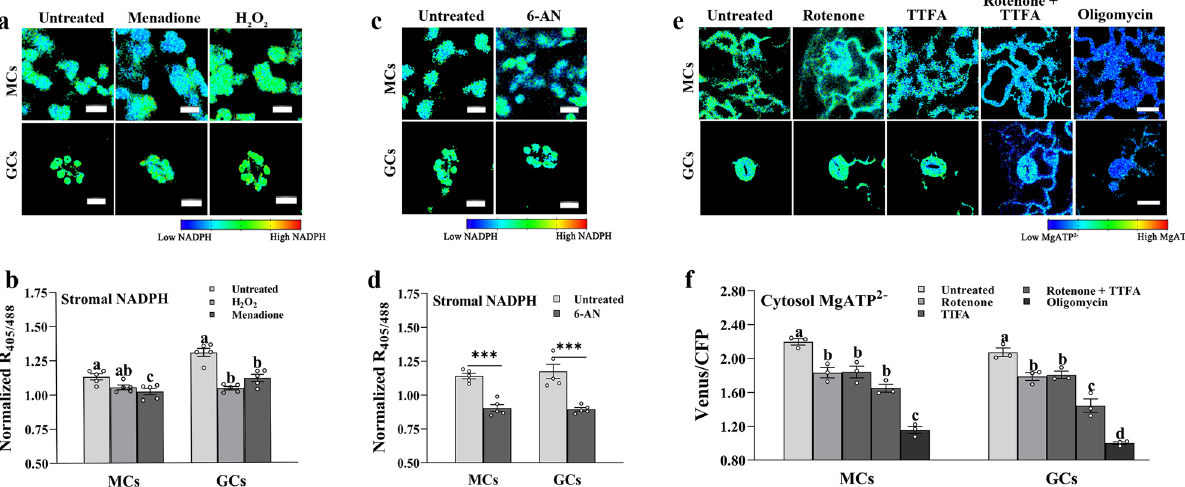
Fig. 3 Effects of various inhibitors on stromal NADPH and cytosolic ATP. a, b Effect of H 2 O 2 and menadione on guard cells (GCs) and mesophyll cells (MCs) expressing the NADPH sensor TKTP iNAP4 in the stroma (one-way ANOVA with Tukey ’ s HSD test at P < 0.05; n = 5; mean± SEM; p -values of panel b (MCs): untreated vs. H 2 O 2 = 0.055, and untreated vs. menadione = 0.008; p -values of panel b (GCs): untreated vs. H 2 O 2 = 0.2× 10 − 4 , and untreated vs. menadione = 0.4 × 10 − 3 ). Different letters indicate signi fi cant statistical differences. Scale bars, 10 µ m. c, d Effect of 5mM 6-aminonicotinamide (6-AN) treatment on GCs and MCs expressing the NADPH sensor TKTP iNAP4 in the stroma. Cells were dark-adapted for 2h prior to treatment with 6-AN (unpaired t -tests, two-tailed at *** P < 0.001; n = 5; mean ± SEM; p -value of panel d (MCs): untreated vs. 6-AN = 0.9 × 10 − 4 ; p -value of panel d (GCs): untreated vs. 6-AN = 0.001). Asterisks indicate statistically signi fi cant differences from untreated control. Scale bars, 10 µ m. e, f Changes in cytosolic ATP levels upon treatment with 0.05mM rotenone, 0.1mM thenoyltri fl uoroacetone (TTFA), 0.01mM oligomycin or 0.05mM rotenone with 0.1 mM TTFA in GCs and MCs (one-way ANOVA with Tukey ’ s HSD test at P < 0.05; n = 3; mean ± SEM, p -values of panel f (MCs): untreated vs. rotenone = 0.005, untreated vs. TTFA = 0.006, untreated vs. TTFA + rotenone = 0.2 × 10 − 3 , and untreated vs. oligomycin = 5.7× 10 − 7 ; p -values of panel f (GCs): untreated vs. rotenone = 0.019, untreated vs. TTFA = 0.03, untreated vs. TTFA + rotenone = 0.4 × 10 − 4 , and untreated vs. oligomycin = 3.1×10 − 7 ). Different letters indicate signi fi cant statistical differences. Scale bars, 20 µ m.Unless stated otherwise, all treated seedlings were incubated in the dark for 1 h before imaging. Ratios of the Venus/CFP and raw iNAP4 ratio before normalization are represented in pseudo-color images, where high ratios (red) correspond to high NADPH level and high MgATP 2 – . Source data are provided as a source data fi